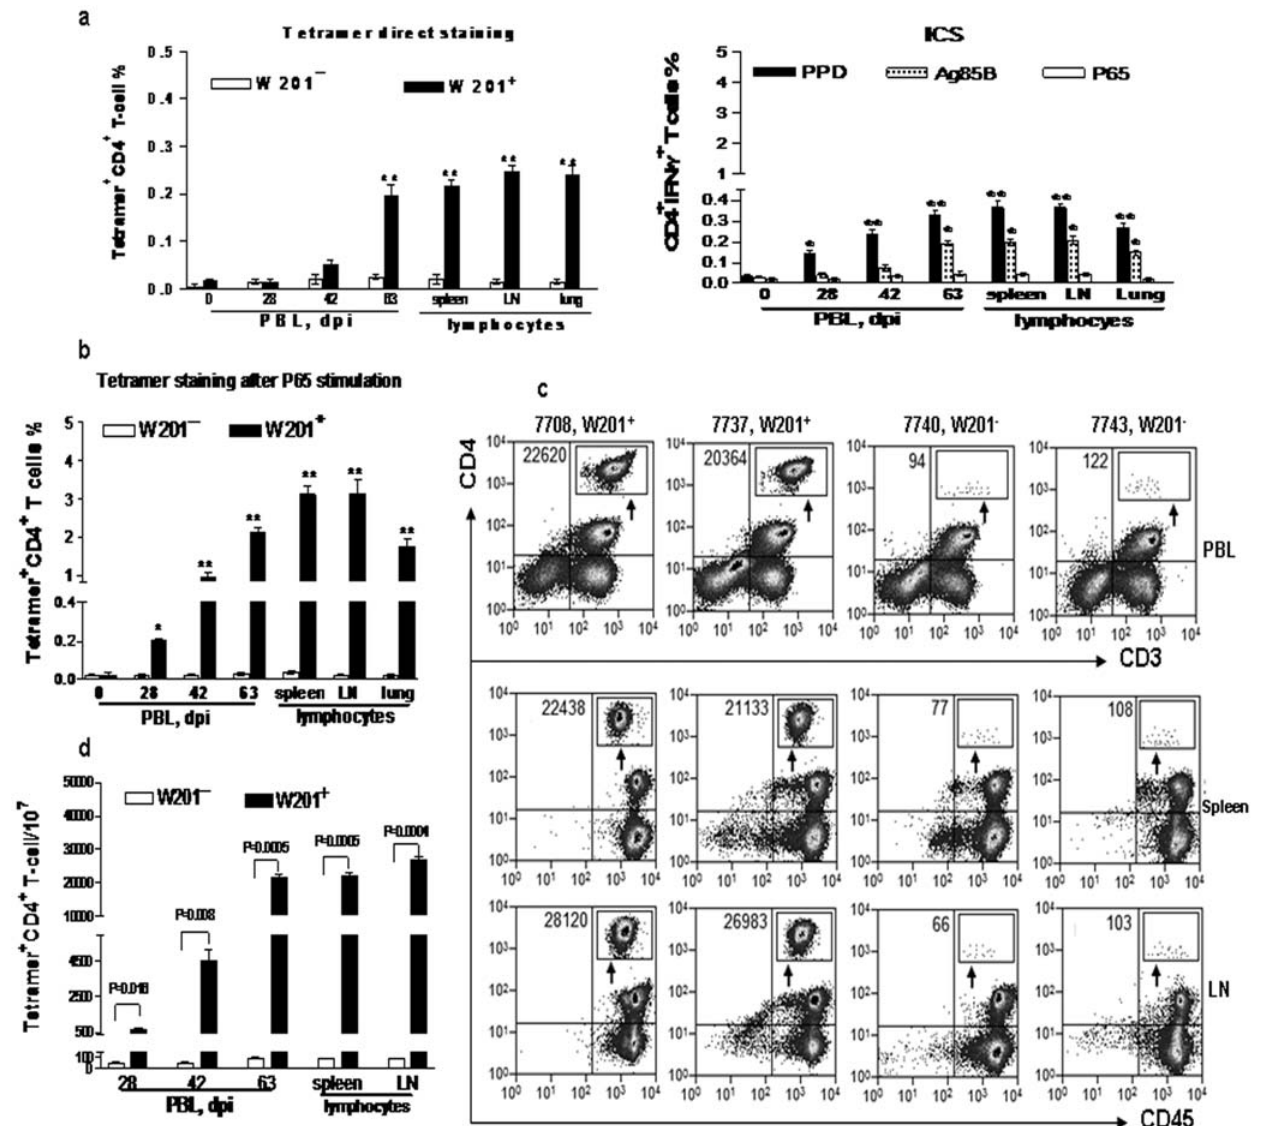
Figure 4. Tetramer-based enrichment conferred high-fidelity to measure P65-specific CD4 cells in comparisons of standard tetramer staining. (a) Left bar graph shows the frequencies of Mamu-DR*W201/P65 tetramer-bound epitope-specific CD4 T cells detected by standard tetramer staining in the different samples after M. tuberculosis infection. Standard tetramer staining detected significant increases in percentages of the P65- specific CD4 T cells in the blood, lymph nodes, spleens, and lungs compared to base line levels in blood or to those of the infected Mamu-DRB*W201 - macaques at day 63 after the infection (**, p , 0.01), but no significance at days 28 and 42 post-infection. Right bar graph shows that ICS does not detect significantly-increased numbers of P65-specific IFN c -producing CD4 T cells after M. tuberculosis infection. (b) The bar graph shows that the tetramer staining after P65 stimulation detects about 10-fold greater numbers of DR*W201 tetramer-bound CD4 T cells in PBL or tissue lymphocytes compared to standard tetramer staining without P65 stimulation (**,p , 0.01; *, p , 0.05). (c) Flow cytometry histograms show that the tetramer-based enrichment approach confers the enhanced ability to enumerate P65-specific CD4 T cells and to distinguish from background staining in 1 6 10 7 PBL or tissue lymphocytes from individual M. tuberculosis -infected monkeys. Tetramer-unbound cells washing out from the microbead column were shown in CD4 versus CD3 or CD45 events in the flow cytometry analysis. The bead-enriched tetramer-bound cells were counted and displayed in the contour plot in the upper right CD4 quadruple, with the total numbers shown in the upper left CD4 quadruple. (d) Bar graph shows absolute numbers of Mamu- DR*W201/P65 tetramer-bound epitope-specific CD4 T cells in 10 7 total cells detected by the tetramer-based enrichment approach in different samples. This enriched approach readily detects significant increases in numbers of the tetramer-bound CD4 T cells in blood at days 28 and 42 post-infection (P=0.016, P=0.008 as indicated) thanks to the much lower nonspecific staining for control samples. This is in sharp contrast to the standard tetramer staining that fails to reveal significant increases in the tetramer-bound cells at these time points due to the relatively-high background staining (Fig. 4a). Also, at day 63 after the infection, the tetramer-based enrichment approach can more dramatically distinguish the tetramer-bound cells from control nonspecific cells (P values 0.0004–0.0005) than the standard tetramer staining (P values